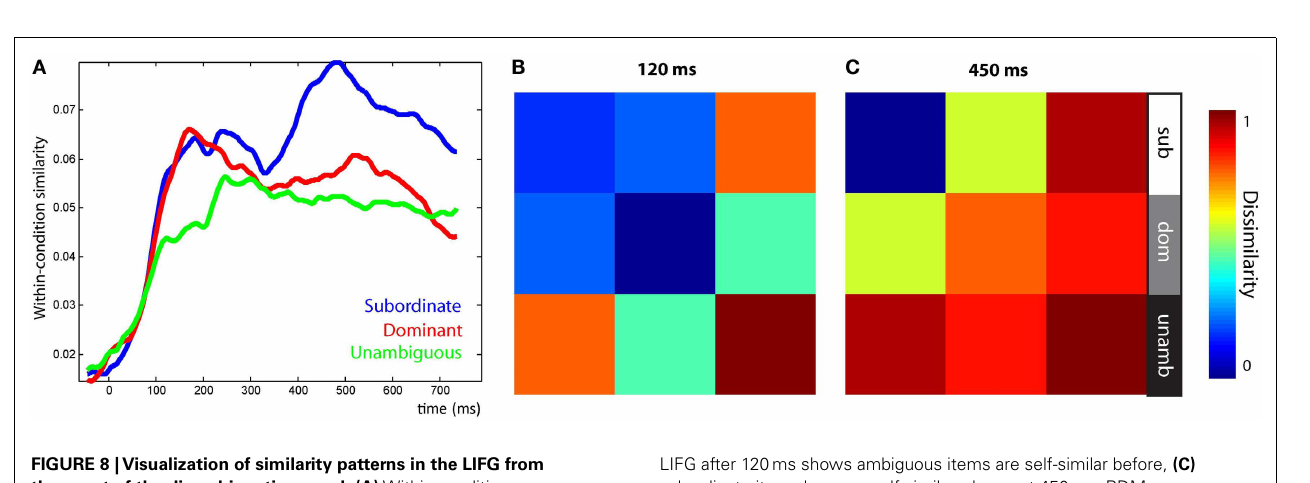
FIGURE 8 |Visualization of similarity patterns in the LIFG from the onset of the disambiguating word . (A) Within-condition similarity time-courses show the group average similarity between items from the same conditions, plotted over time. (B) RDM of the